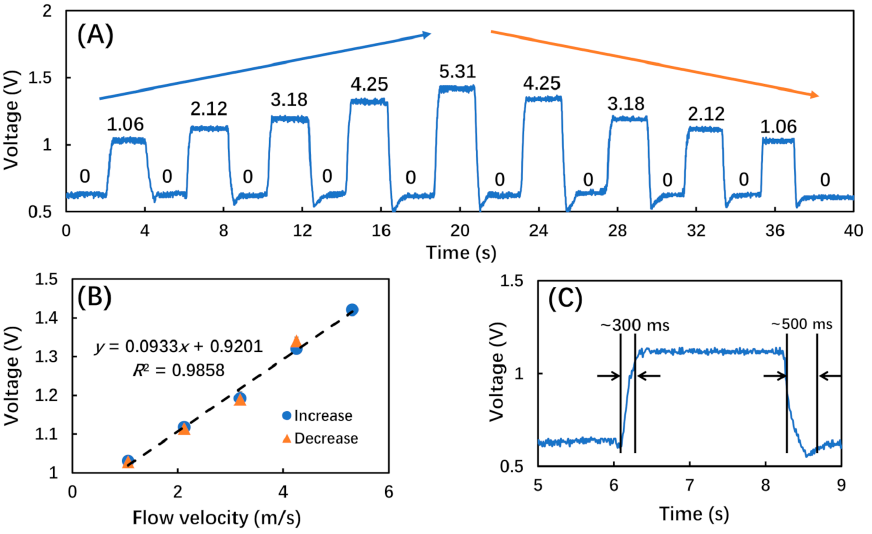
Figure 5. The responses of the breath sensor under airflow pulses at different flow velocities. ( A ) The amplitude of the reflected light under airflow pulses at different flow velocities (marked above the corresponding voltage data curves, unit: m/s); ( B ) linear fitting of output voltage data as a function of flow velocity; ( C ) a zoomed-in representative response under an airflow pulse of 2.12